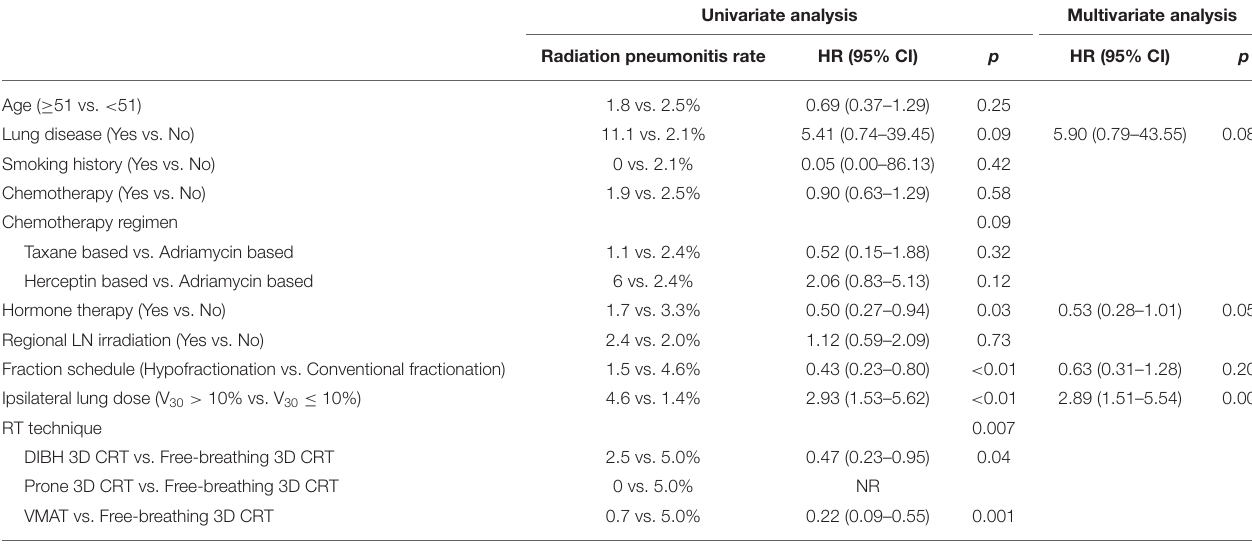
TABLE 3 | Univariate and multivariate analysis of factors associated with symptomatic radiation pneumonitis.